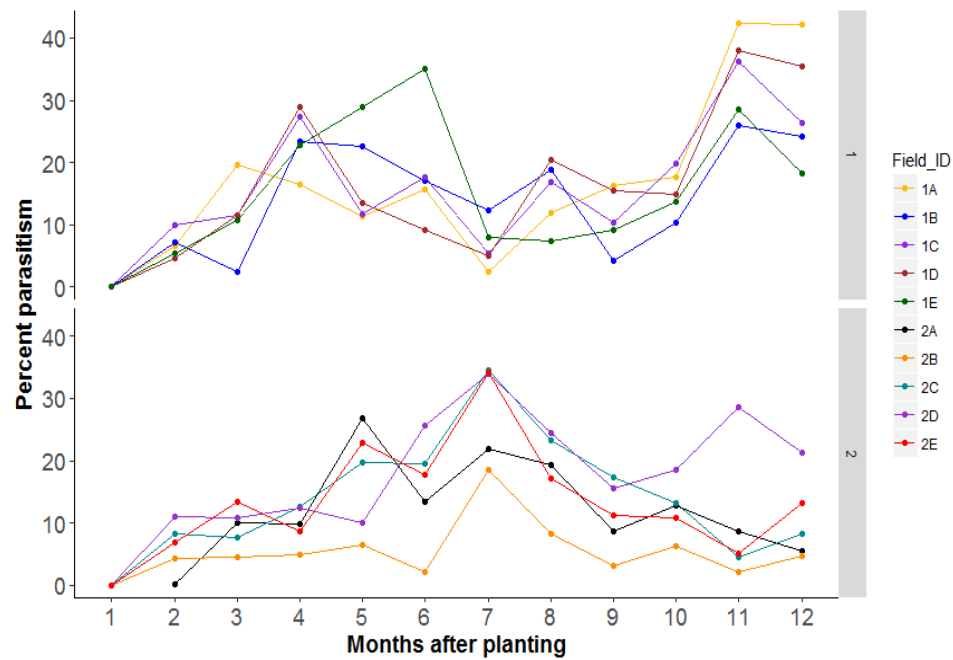
Figure 8. Change in parasitism level across time.